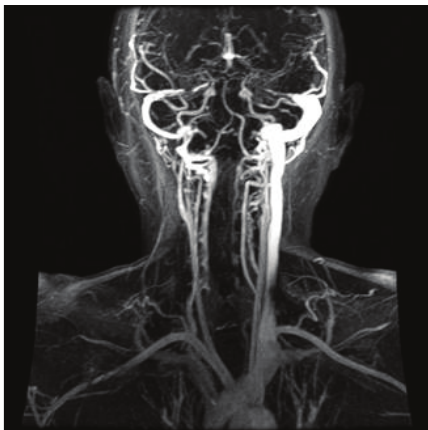
Figure 2: Sagittal view of venous system (dynamic magnetic resonance image). Please note that right filling of IJV with the radiopaque contrast is absent, markedly, from the bifurcation. Moreover, left IJV is seen thickened.